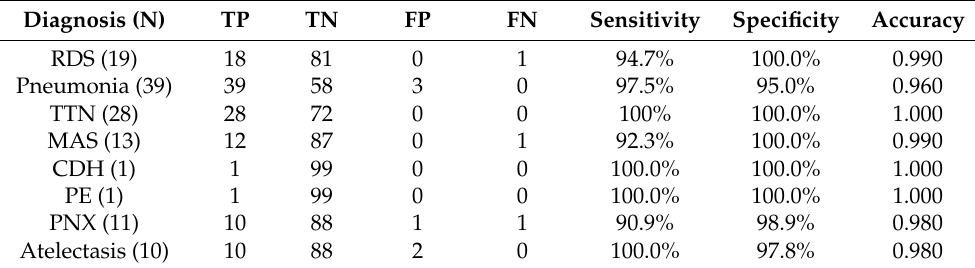
Table 2. Sensitivity, specificity and accuracy regarding LUS in studied respiratory